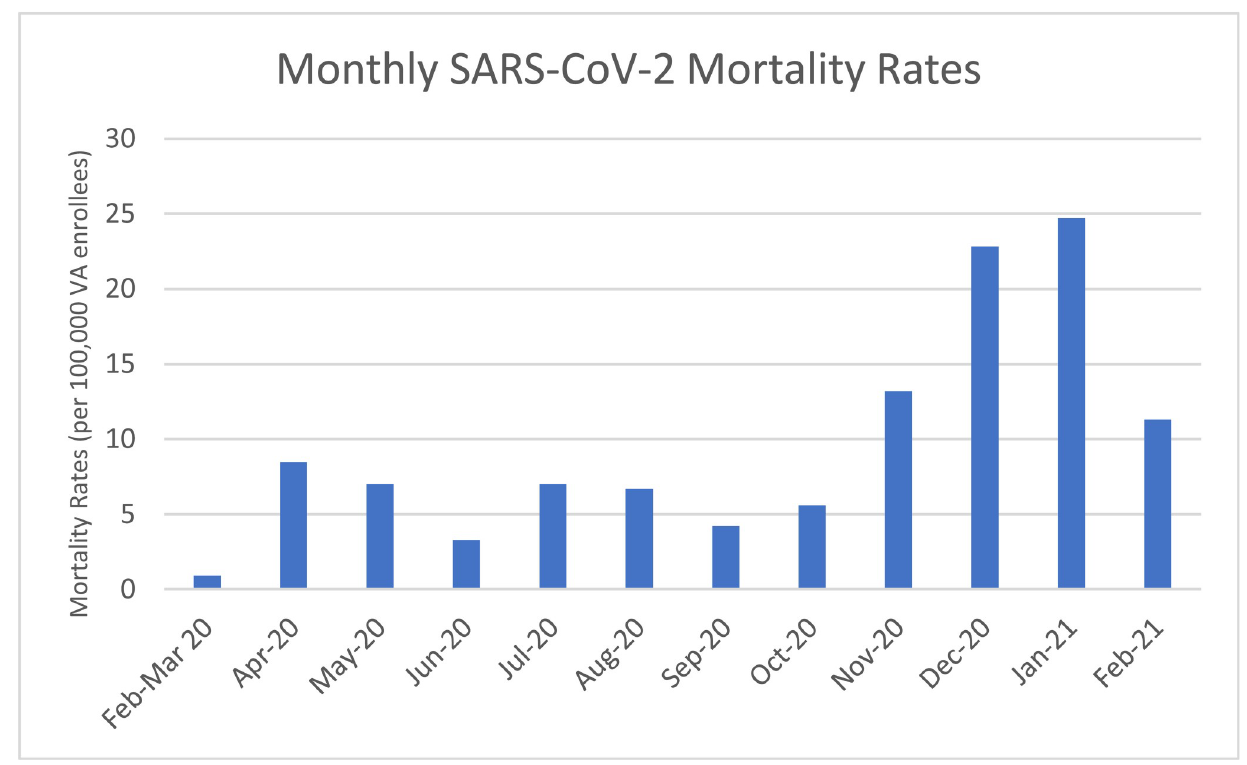
Fig 2. Monthly results in the VA healthcare system from February 2020 to March 2021 of SARS-CoV-2 mortality rates among a cohort of VA enrollees. SARS-CoV-2, Severe Acute Respiratory Syndrome Coronavirus 2; VA, Veterans Affairs.